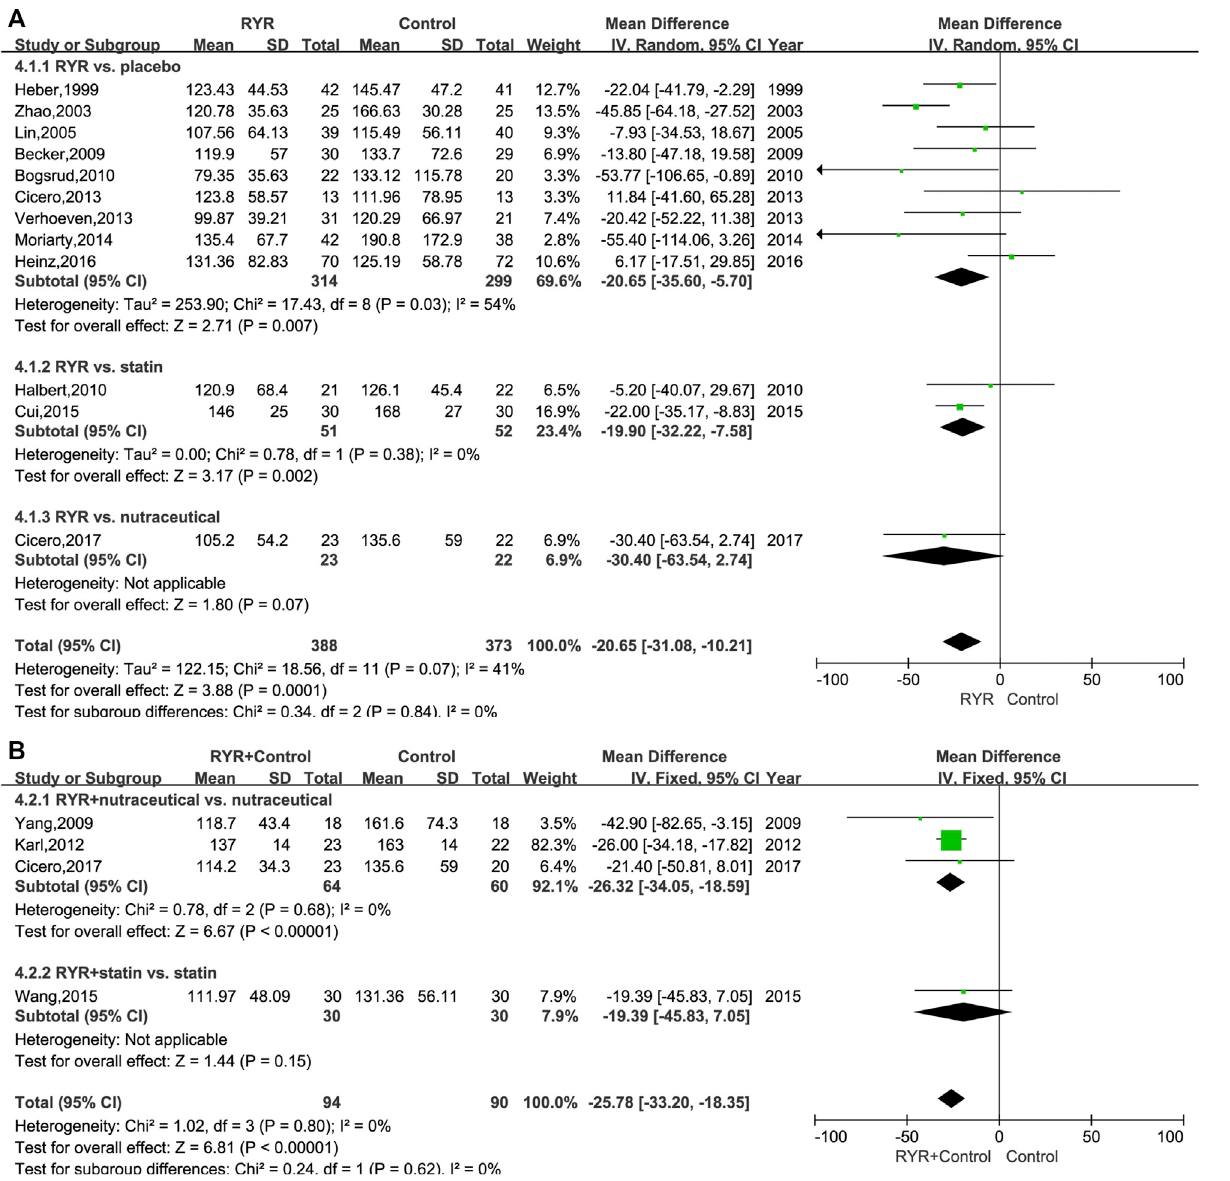
FIGURE 4 | (A) Forest plot of TG between RYR alone and control groups. (B) Forest plot of TG between RYR in combination and control groups. (RYR: red yeast rice; TG: triglyceride).